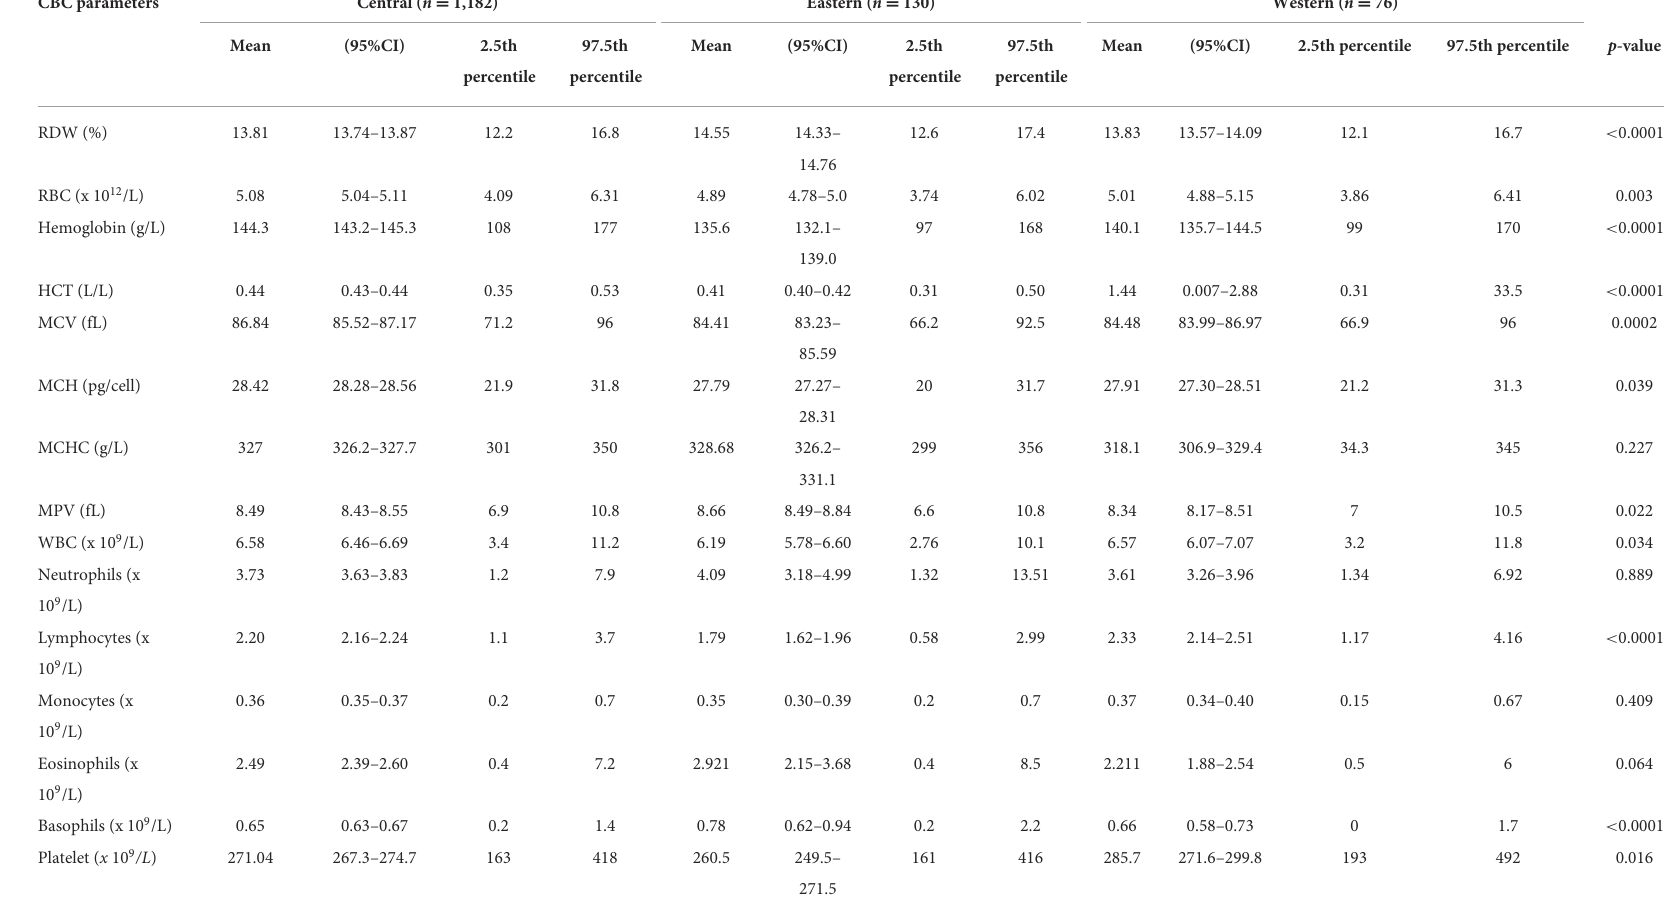
TABLE 3 The CBC reference intervals of the study cohort by